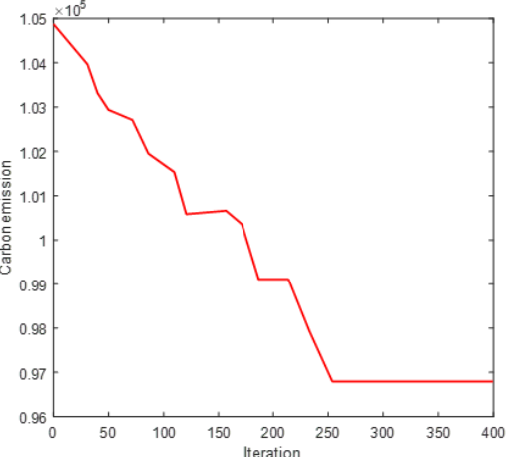
Figure 18. Carbon emissions target iterative curve of EGA algorithm.